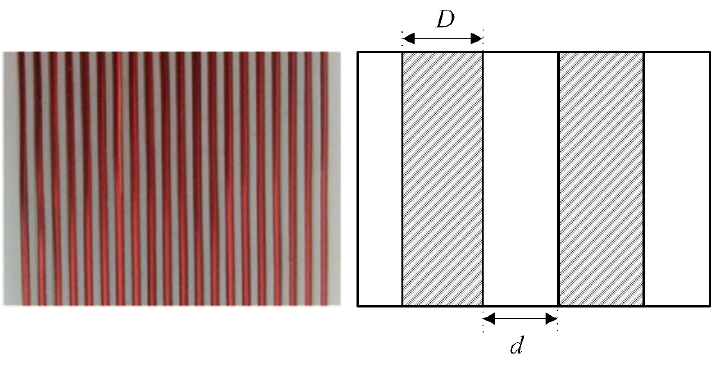
Figure 9. Excitation coil.